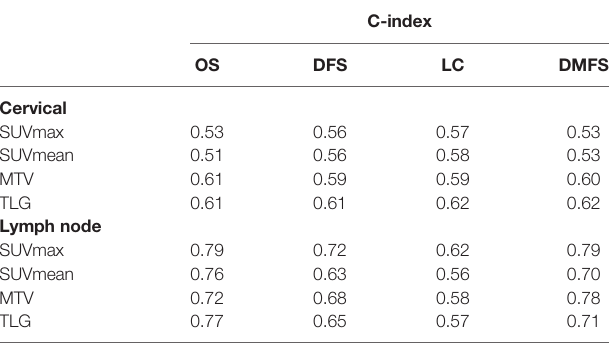
TABLE 2 | The c-index values of SUVmean, SUVmax, MTV, and TLG of the primary lesion of the cervix or lymph node for OS, DFS, LC and